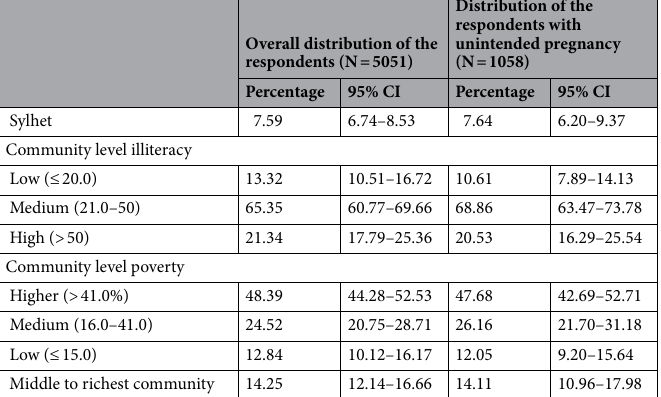
Table 1. Background characteristics of the respondents, Bangladesh, 2017/18.